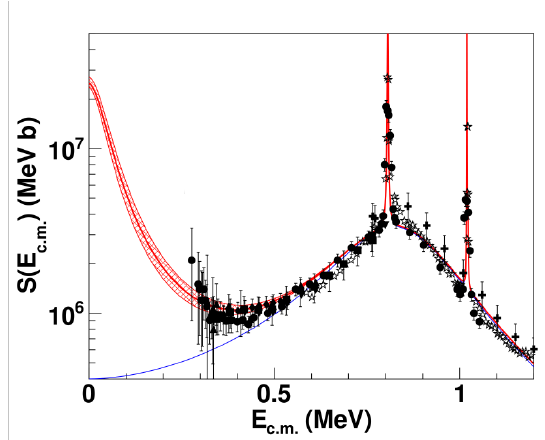
Figure 2. R-matrix calculated S(E)-factor of the 13 C( α, n ) 16 O reaction (red band) from Ref. [22]. The R-matrix S(E)-factor not including the threshold resonance is displayed by the blue line. Black symbols are used for direct data normalized as in [37]. Di ff erent marks are used for each data set: diamonds for [38], crosses for [39], downward triangles for [40], squared for [41], circles for [36], stars for [42] and upward triangles for